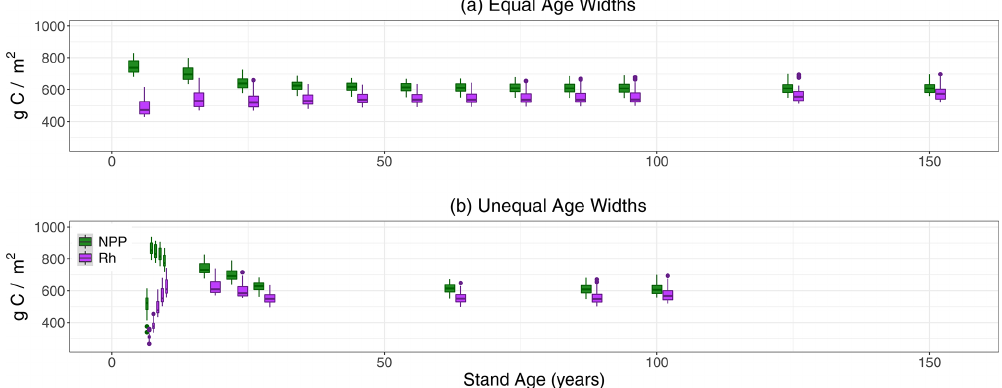
Figure 4. Boxplots of NPP and Rh by age classes ( x axis, in years) from LPJ-wsl v2.0 simulations for US states MI, MN, and WI, for simulations using (a) equal-bin age widths and (b) unequal-bin age